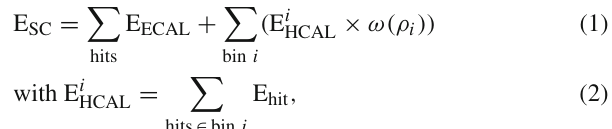
The energy of calorimeter clusters are computed